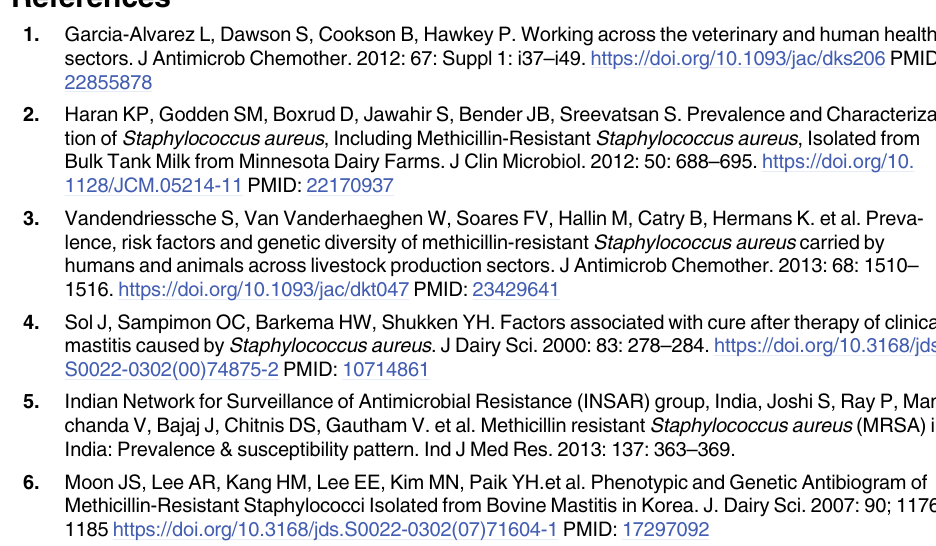
S1 Fig. Antimicrobial resistance to Oxacillin and Cefoxitin identified by strip method of Staphylococci isolated from dry cows in India. S2 Fig. Amplicons of the groEL gene by PCR of coagulase negative Staphylococci isolated from dry cows in India. S3 Fig. Restriction Fragment Length Ploymorphism patterns of groEL gene by PCR-RFLP of coagulase negative Staphylococci isolated from dry cows in India. S4 Fig. Amplicons of the blaZ gene in Staphylococcus aureus . S5 Fig. Amplicons of the mecA gene in Staphylococcus aureus